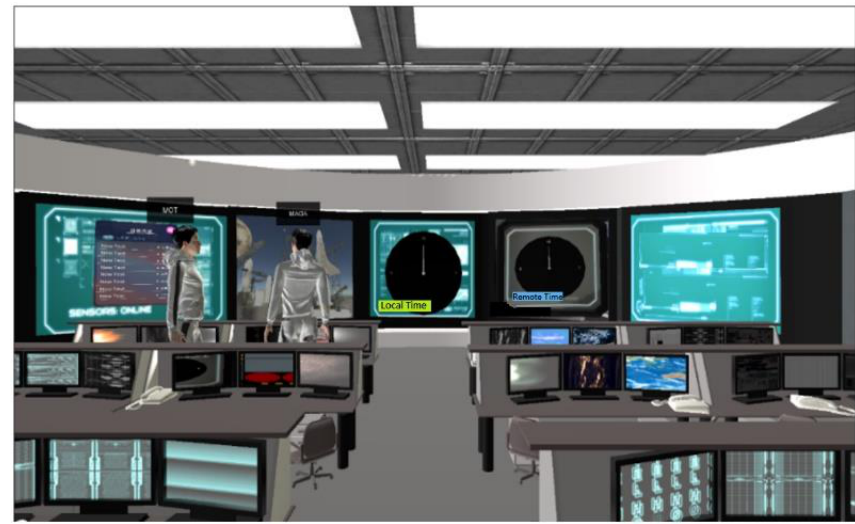
Figure 7. Virtual scene of the control room at the launch station. If the learner answers a question incorrectly, they can choose to answer it again by reading the learning content on the screen of the control room for verification. After answering all questions correctly, the learner can enter the spacecraft to start the exploration mission. The rocket will carry the spacecraft slowly up into the sky, out of the range of gravity, and finally into outer space (Figure 8). The learner can adjust the speed and direction of the spacecraft and drive it towards the destination.